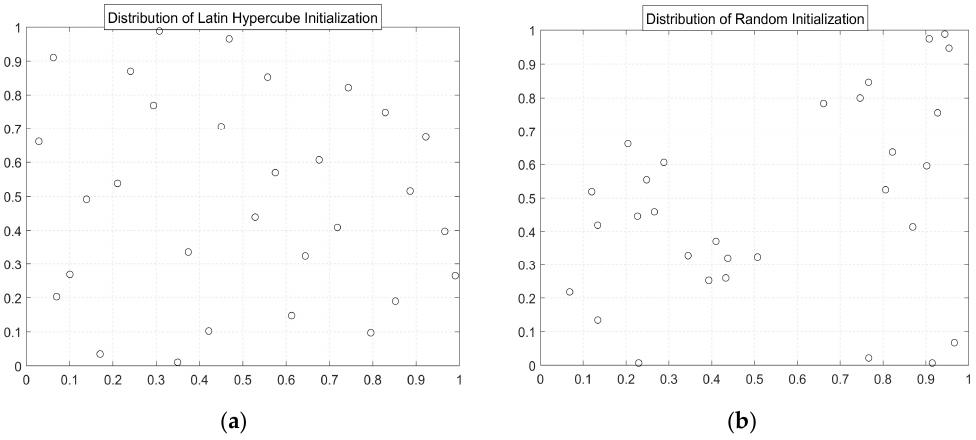
Figure 10. Distribution of ( a ) Latin hypercube and ( b ) random initialization.